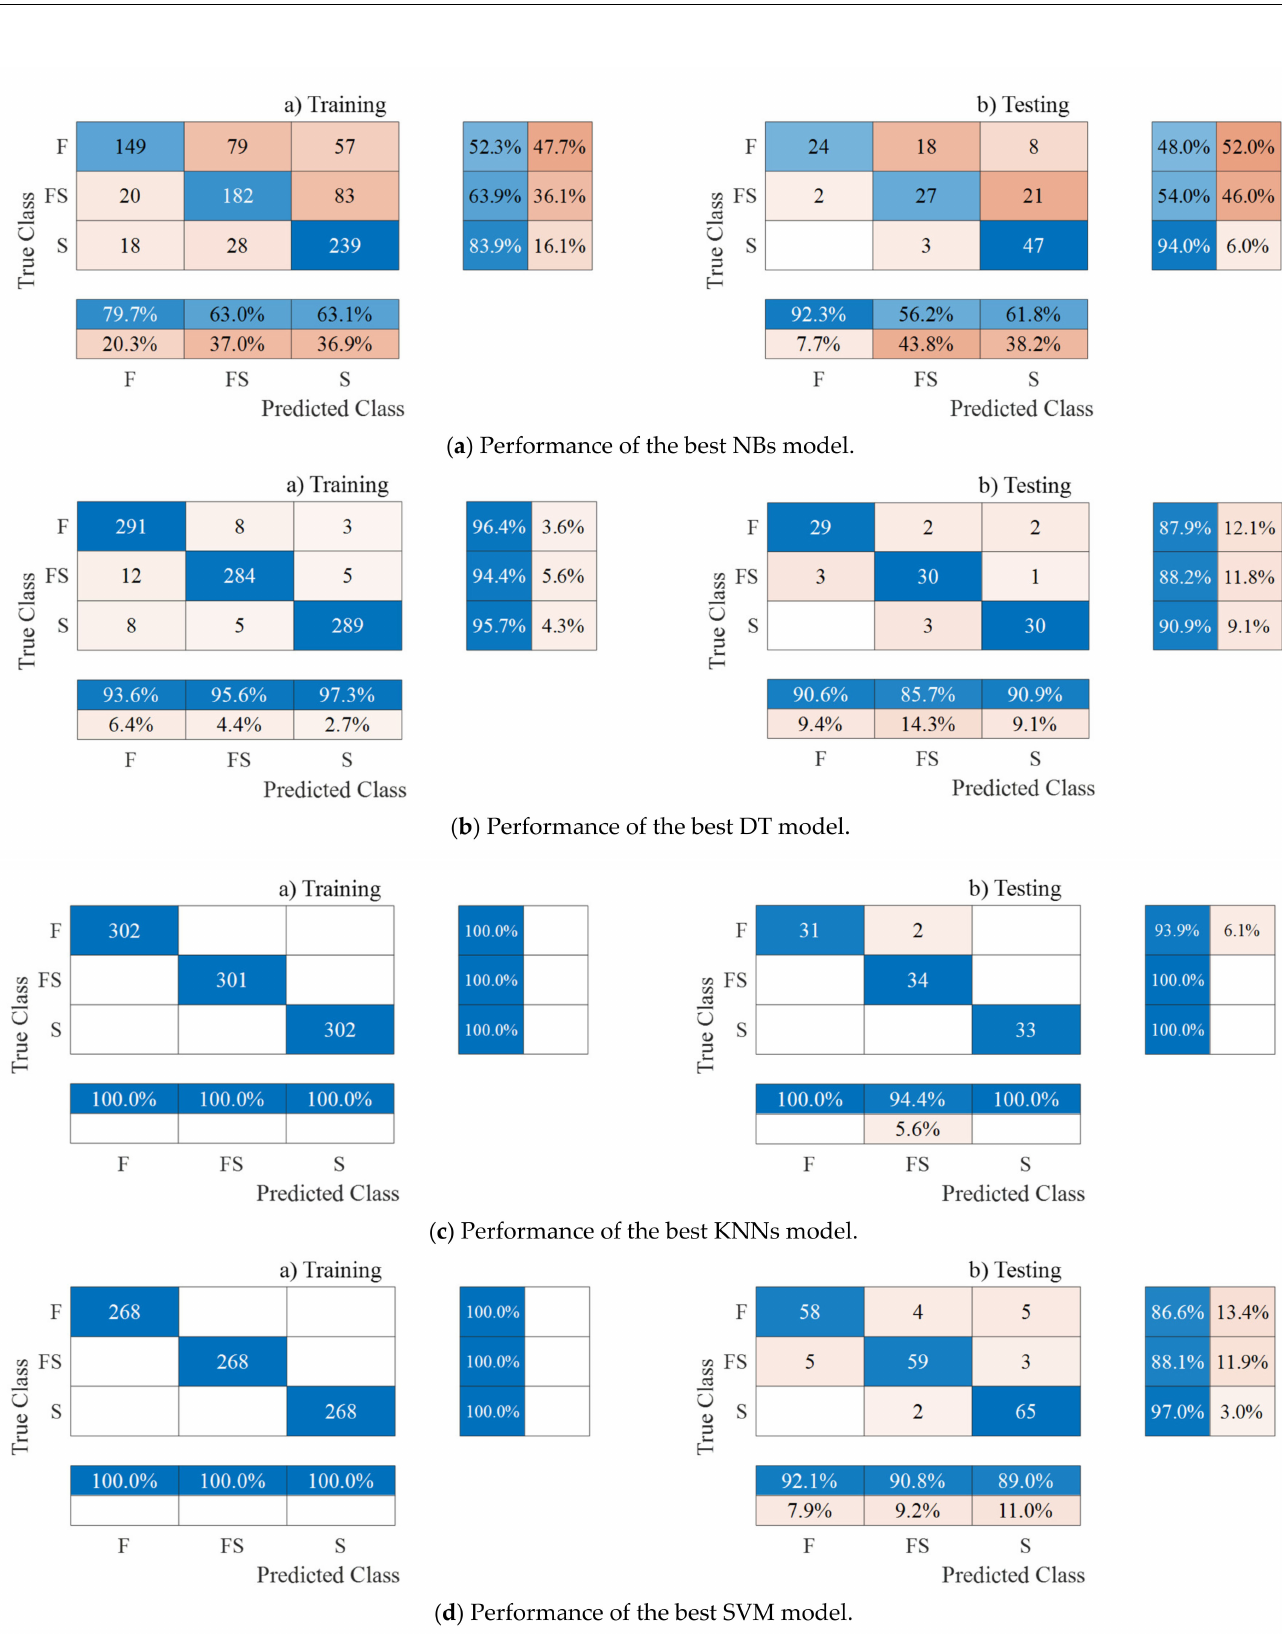
Figure 18. Confusion matrix of classified failure modes using different